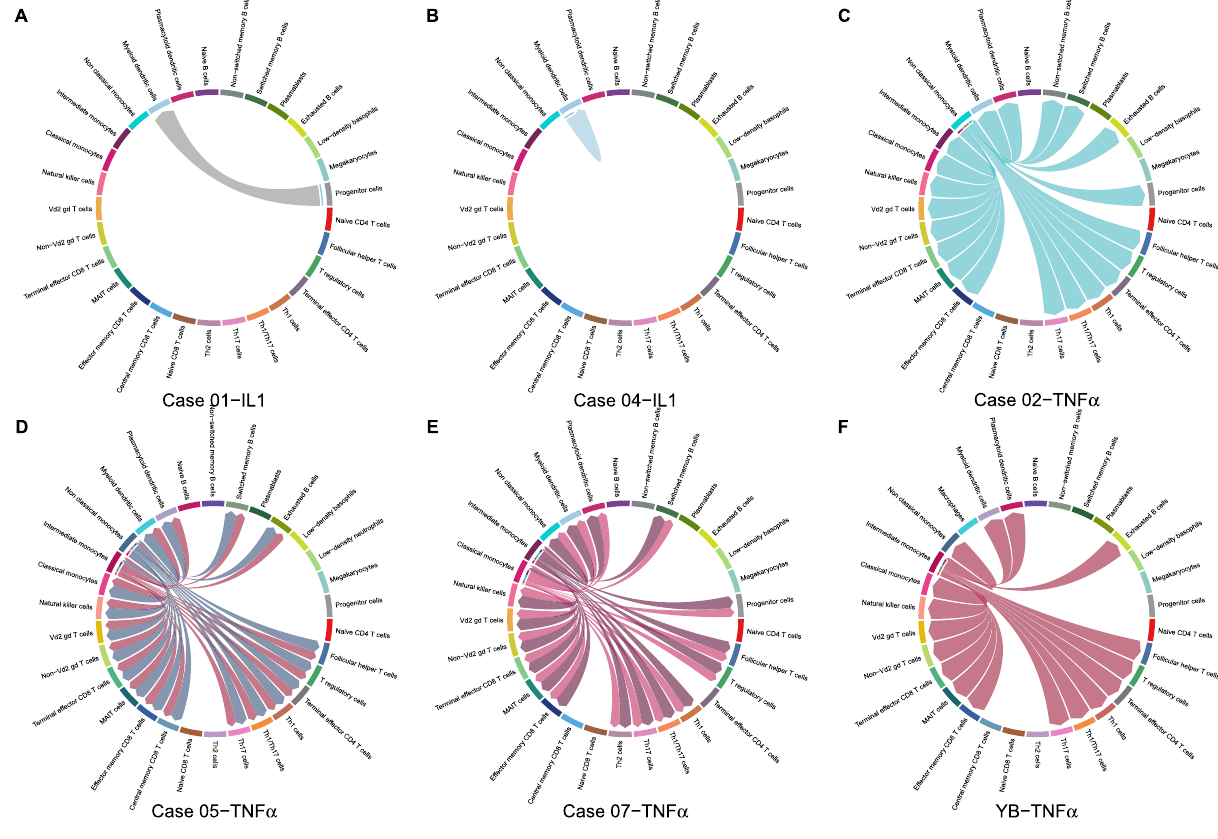
Figure 5. Cell–cell interaction signaling of IL-1 and TNF-α. ( A , B ) IL-1 signaling for Cases 01 and 04. ( C – F ) TNF-α signaling for Cases 02, 05, 07, and hyperuricemia (uric acid = 7.2) health control YB. Arrows from source cells to target cells indicate inferred signaling ligand secretion and reception.